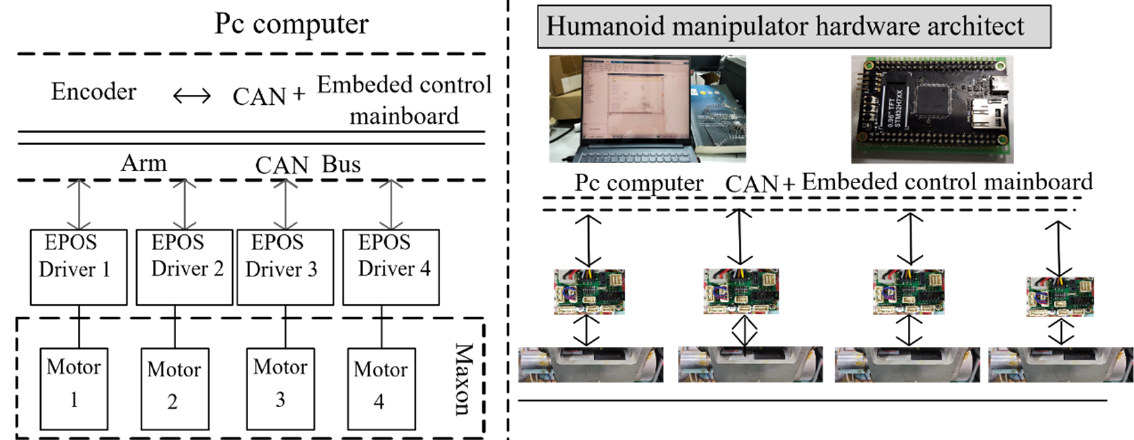
Figure 7. The architecture of the humanoid manipulator system. Table 10. Parameters of DFONTSM-STA control.